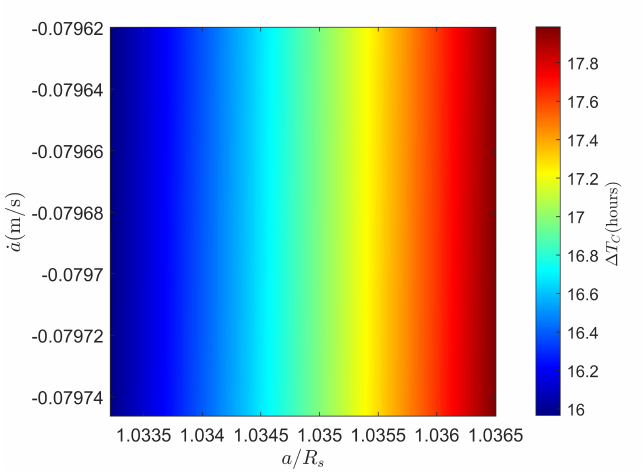
Figure 8. The semimajor aixs compensation period ∆ T C (hours) for repeating ground track orbits where a ∈ [ 62,268, 62,468 ]